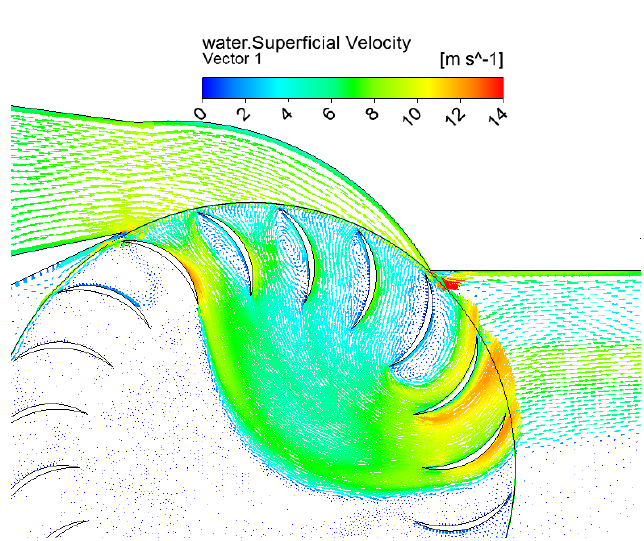
Figure 3. Water velocity vectors illustrating the flow separation on the blades at the first stage of the 7 kW turbine at η max = 69%. Note that there is no flow separation on the second stage [5].